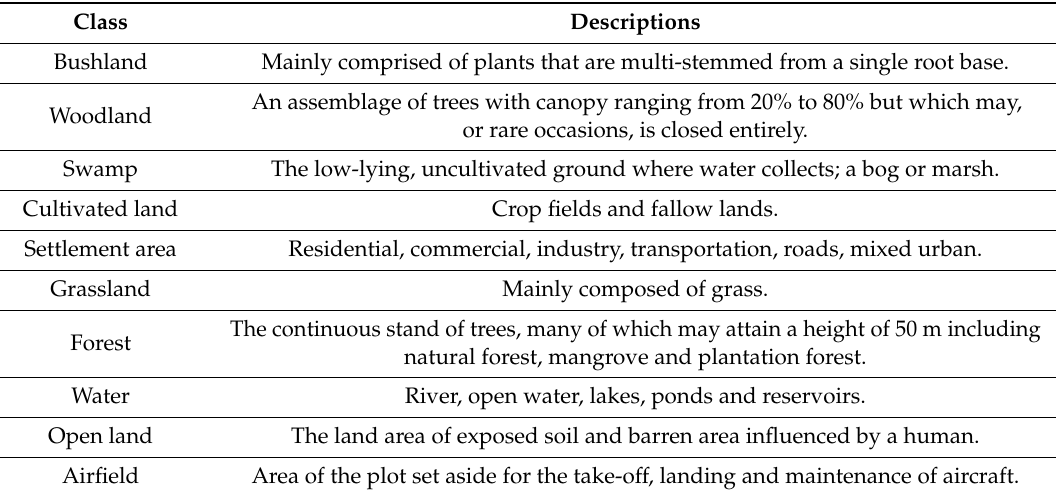
Table 2. Land-use and land-cover (LULC) classification